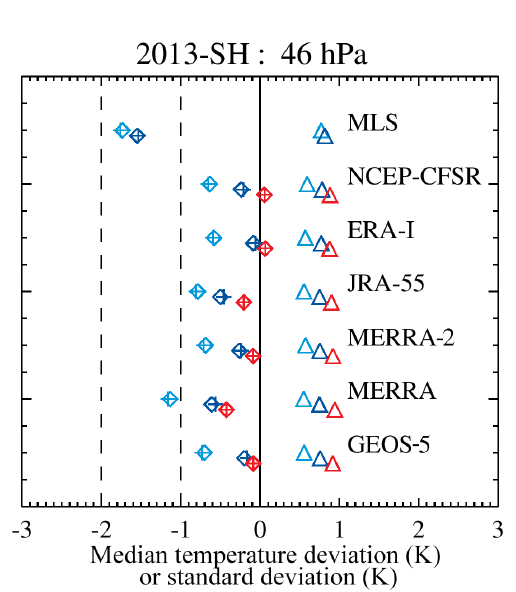
Figure 14. Median deviations (diamonds) and standard deviations (triangles) of the temperature distributions for LIQ (cyan), ICE (blue), and COSMIC (red) for each reanalysis, GEOS-5.9.1, and MLS, for a representative year (2013) at 46hPa. The plus symbols denote the means of the distributions. Their similarity to the median values indicates that the distributions have small